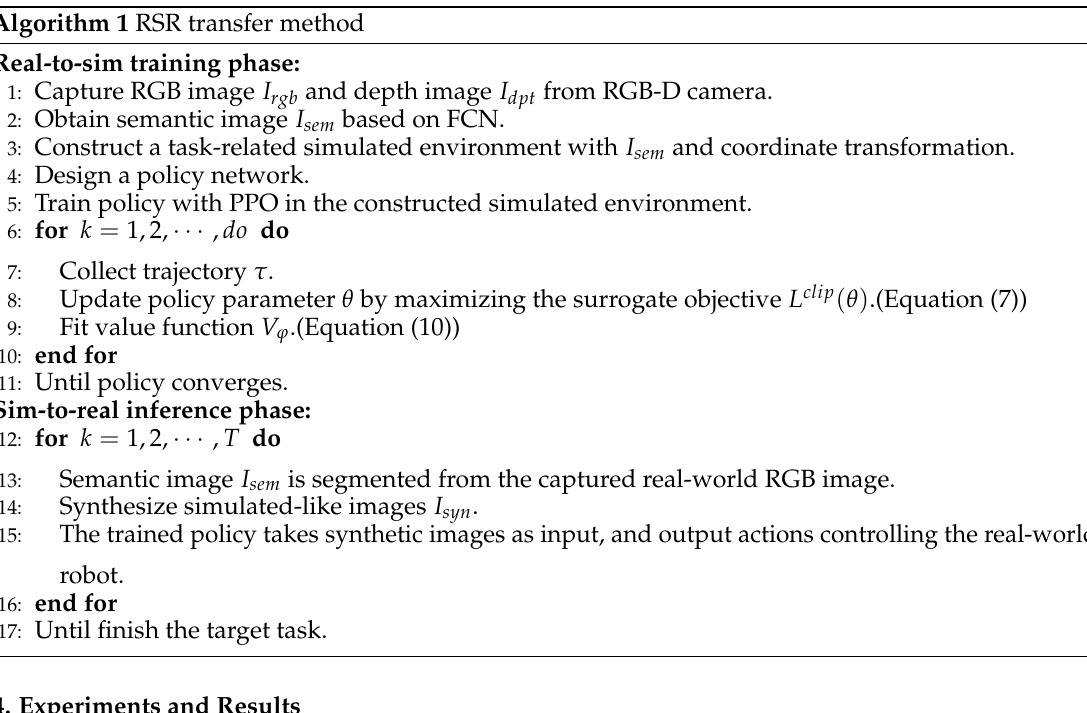
Algorithm 1 RSR transfer method